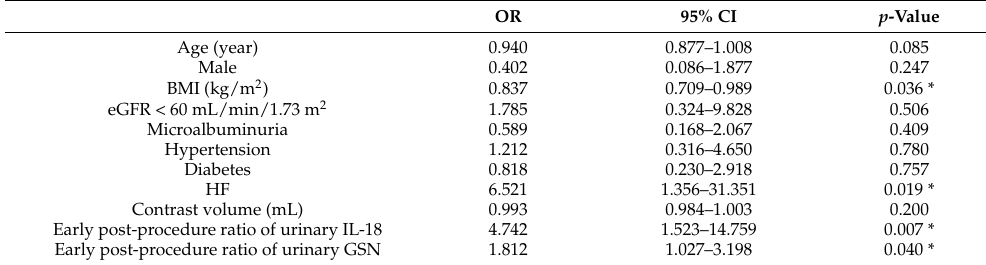
Table 2. Factors Independently Associated with AKD after Cardiac